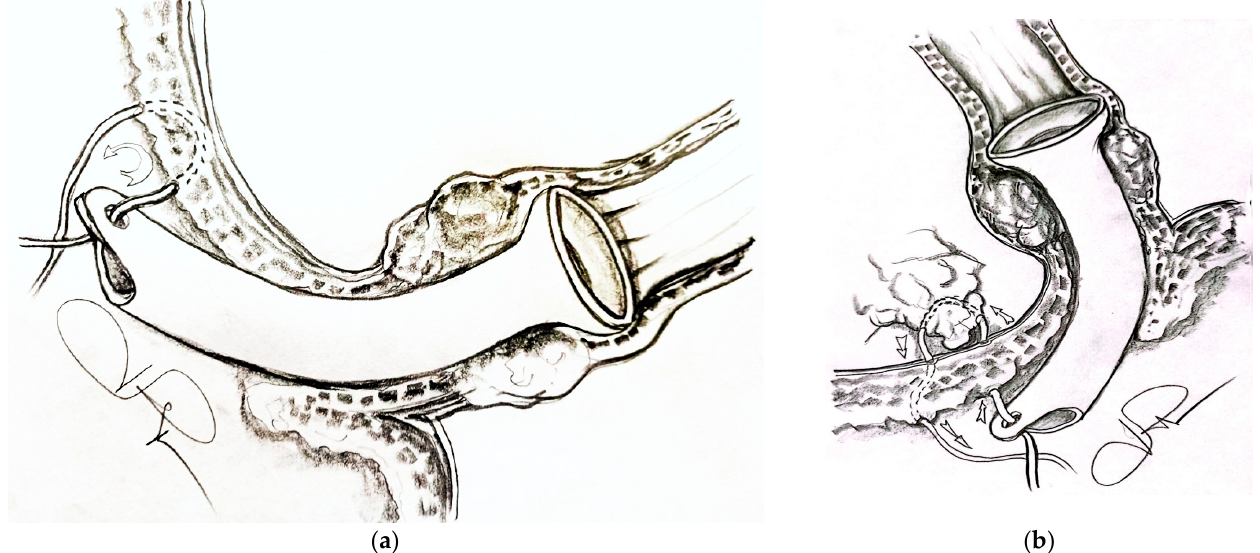
Figure 5. ( a ) Endogastric fixation of stent and ( b ) transparietogastric fixation of stent.